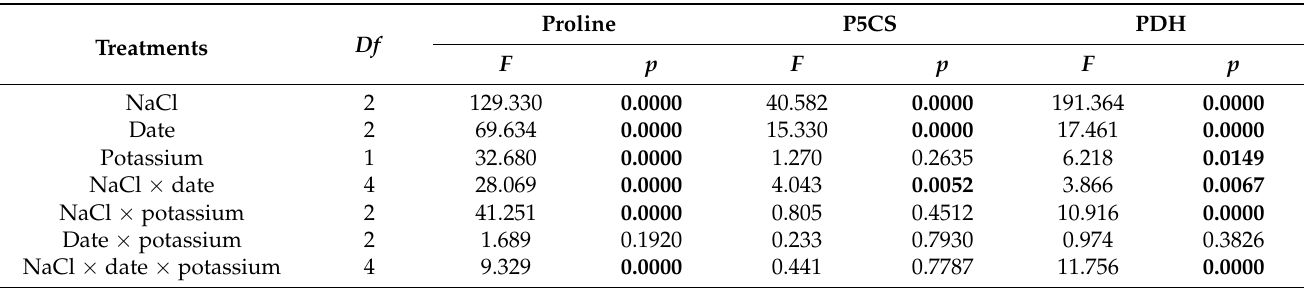
Table 6. ANOVA results for proline content and P5CS and PDH activity in the leaves of zinnia exposed to salinity with two potassium doses in the peat substrate.